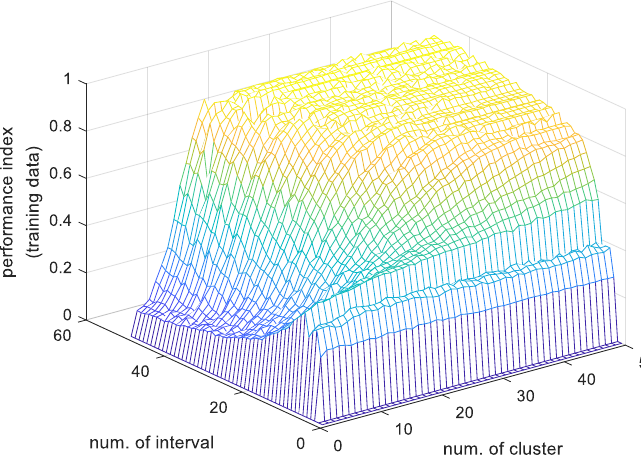
Figure 16. The variation of performance index (training data).